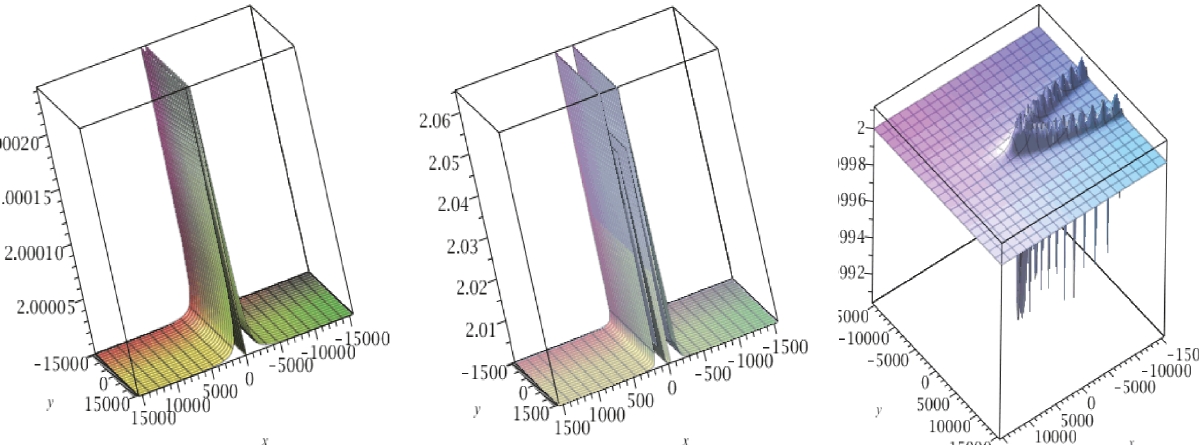
= 0 , 𝑏 = 10 3 , 𝑎 = 0 , and 𝑏 = 0 . 1 1 2 2